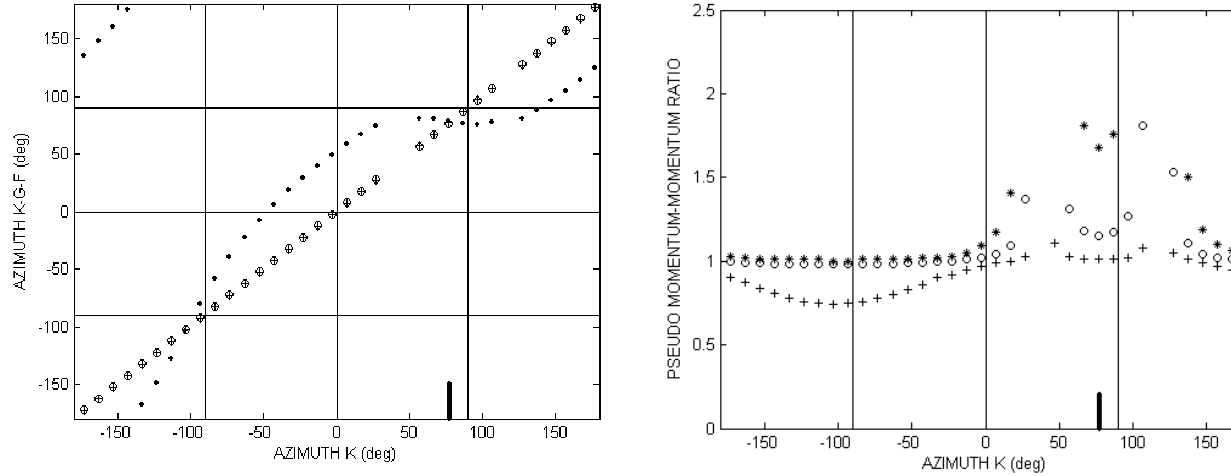
Fig.B1 The horizontal axis is the azimuth angles of the horizontal wave vector ( ) l , k , Fig. B1. The horizontal axis is the azimuth angles of the hori- and the vertical axis are: ‘cross’ denoted the azimuth angle of horizontal wave zontal wave vector (k,‘) , and the vertical axis are: cross denoted vector ( ) l , k ; ‘ open circle’ denoted azimuth angle of the horizontal the azimuth angle of horizontal wave vector (k,‘) ; open circle de- ~ ,~ ( ) noted azimuth angle of the horizontal momentum vector momentum vector PP ; ‘ dot ’ denoted the azimuth angle of the horizontal yx dot denoted the azimuth angle of the horizontal group velocity (cid:0) v (cid:1) . The short thick vertical line indicated the azimuth angle group velocity ( ) vv , . The short thick vertical line indicated the azimuth gx ,v gy gygx of the winter mean wind velocity (37.8, 8.1)m/s. The phase velocity angle of the winter mean wind velocity (37.8, 8.1) m/s. The phase velocity and and the wave period of this gravity wave were 30m/s and 143min, the wave period of this gravity wave were 30m/s and 143min respectively. respectively.